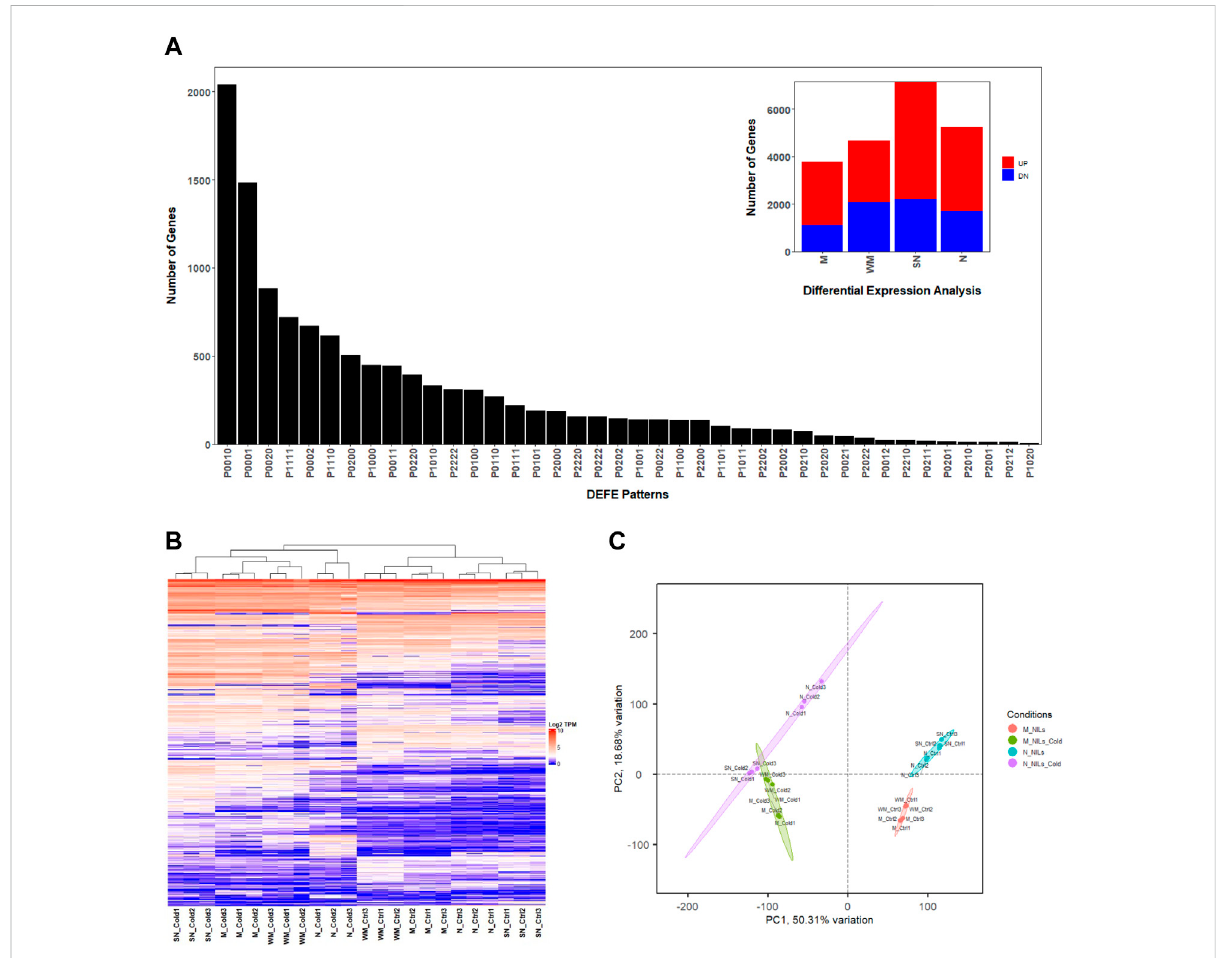
FIGURE 1 Transcriptome overview based on the 12,676 DEGs. (A) Frequency distribution (insert) and top 40 patterns of P series of DEFE analysis; (B) Heatmap; (C) Principal component analysis, where PC1 and PC2 are principal components 1 and 2,